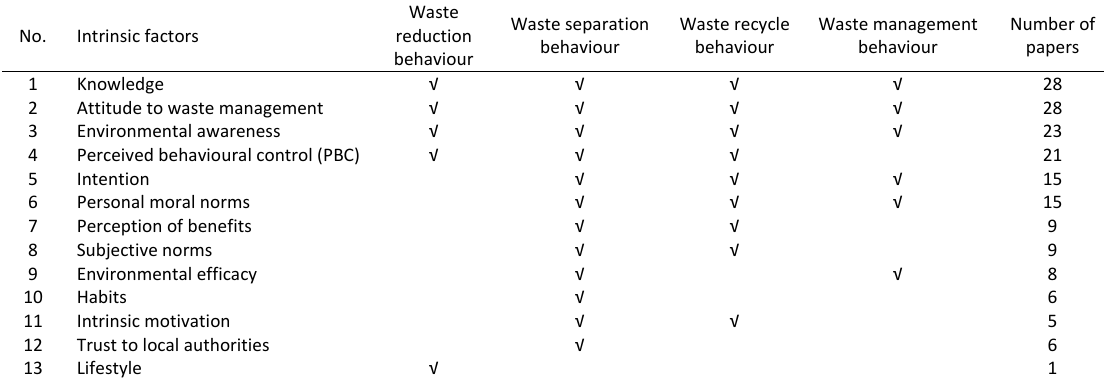
Table 4: Identified intrinsic factors affecting waste management behaviour No.